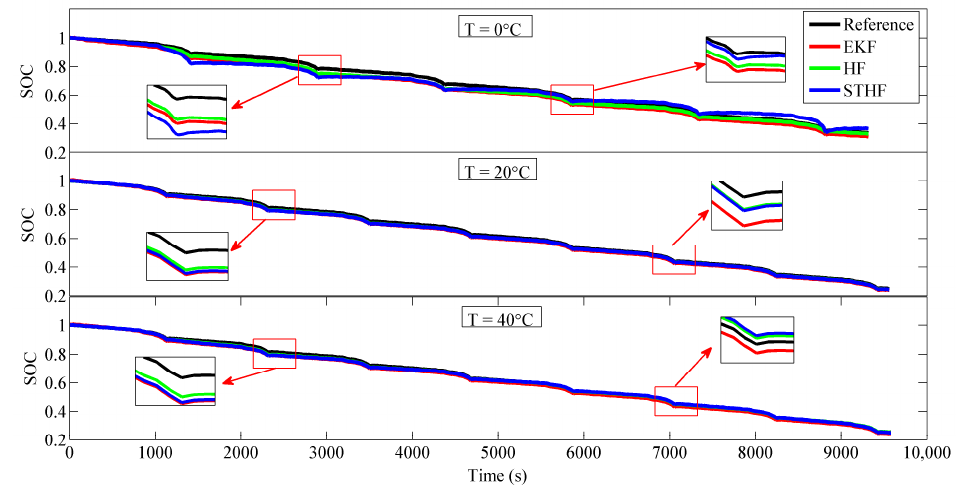
Figure 8. Estimation results of STHF, HF, and EKF with 0.05 A current-biased noises.